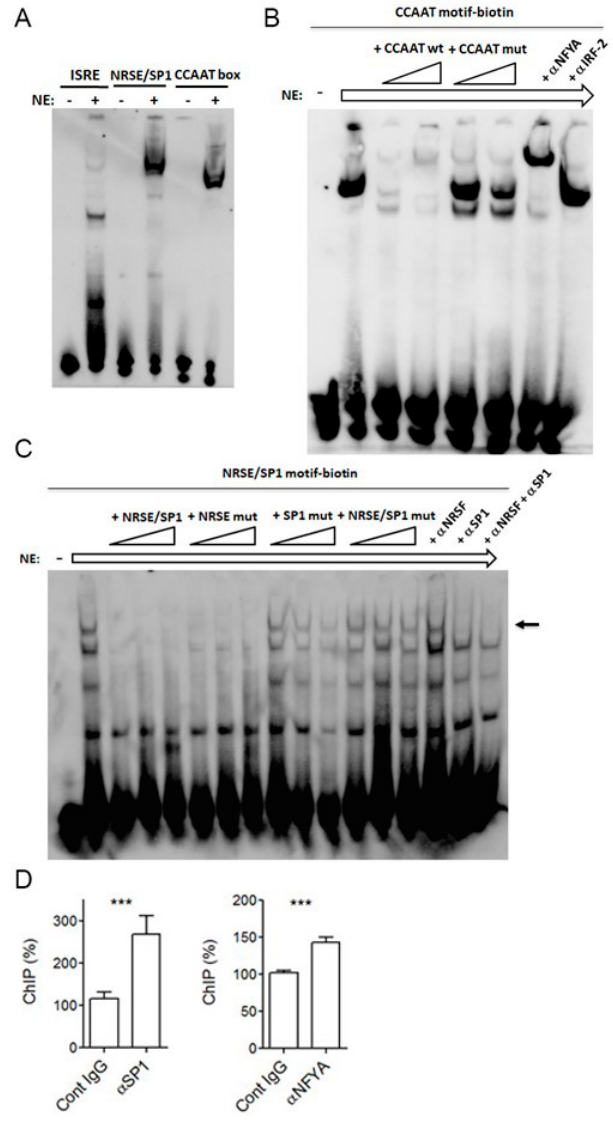
Figure 3. Mapping transcription complex binding sites in the 400-bp PNPT1 promoter using EMSA and ChIP. ( A ) biotinylated double-stranded oligonucleotides representing the indicated cis-elements of 400 bp- PNPT1 promoter were used for EMSA assays. SP1 and NRSE-like motifs overlap and were present in a single oligonucleotide. DNA fragments were incubated in the presence (+) or in the absence (–) of nuclear extracts (NE), and the resulting complexes were analyzed by nondenaturing PAGE and biotin detection. ( B , C ) the complexes observed in ( A ) were further competed with, either, growing concentrations of the identical unlabeled oligonucleotide or the corresponding point mutated counterpart, or antibodies to the indicated polypeptides. ( C ) the arrow points out the complex that is competed with the unlabeled oligonucleotide containing a native SP1 motif or with α SP1 antibodies but not with the native NRSE motif or the presence of α NRSE antibodies. Shown are representative EMSA. ( D ) SP1 or NFYA chromatin immunoprecipitation in HeLa cells. Immunoprecipitation was performed with antibodies to SP1 or NFYA and the corresponding unspecific control antibody (Cont IgG). Enrichment relative to controls was determined by real-time PCR and expressed as a percentage (fold) over control. Shown are representative ChIP assays performed in triplicate (mean ± SD). Two different pairs of oligonucleotides encompassing the promoter region yield similar results. Statistical analysis: t -test, *** p < 0.001 ( n = 6 independent